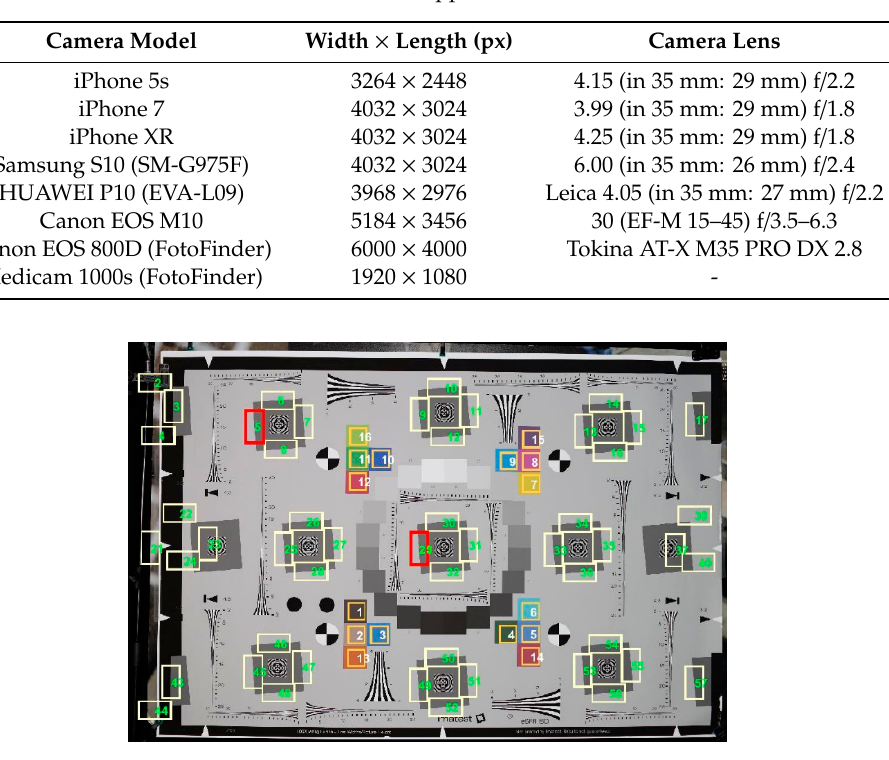
Table 1. Cameras applied in the test.